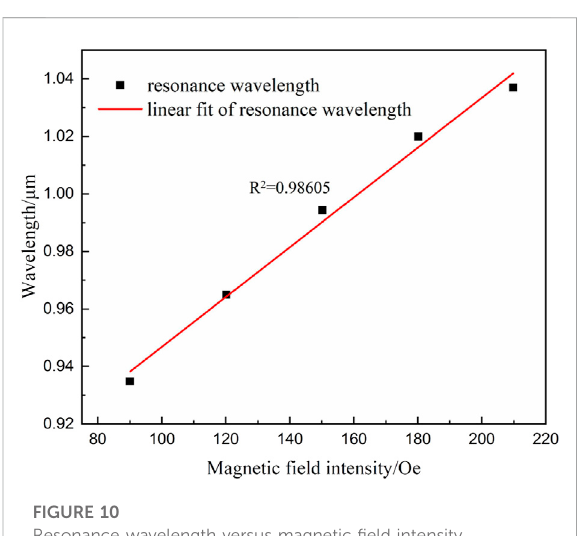
FIGURE 10 Resonance wavelength versus magnetic fi eld intensity.